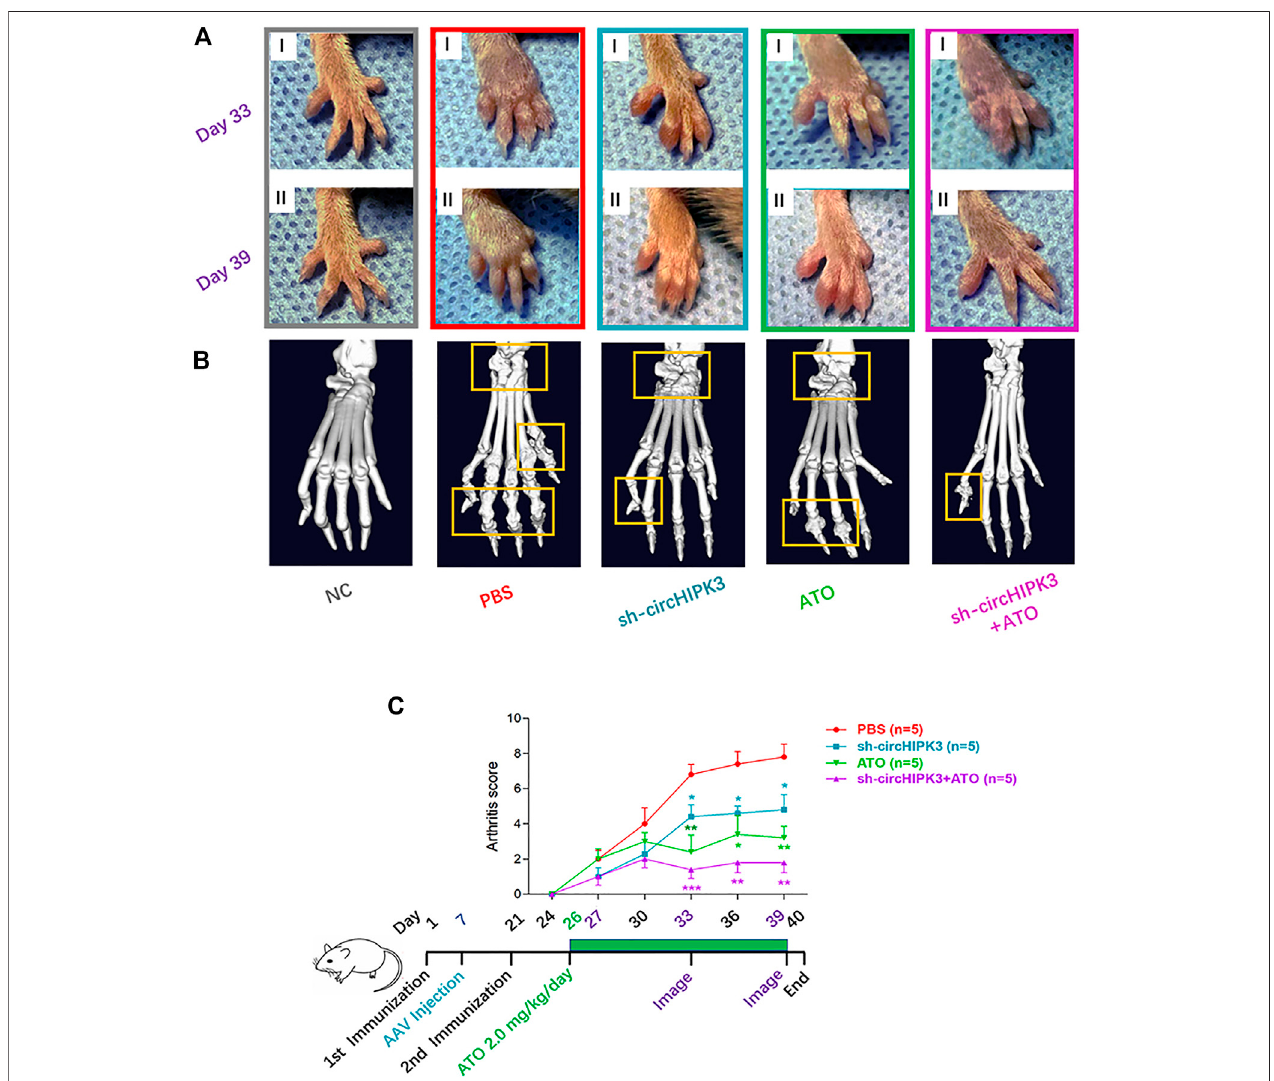
FIGURE5 | CircHIPK3knockdown or its combined application withATO alleviated the symptoms and jointdestruction ofCIA mice. (A) Representative pictures of the paws of mice showed that CIA developed rapidly in paws after the mice were immunized with collagen II and sustained to the end of the experiment. AAV-sh- circHIPK3, 2.0 mg/kg/day ATO administration, or the combination treatment of above two agents signi fi cantly alleviated the severity of arthritis compared with the CIA grouponday33( Ⅰ )andday39( Ⅱ )afterthe fi rstimmunization. (B) Themicro-CTimagesofpawsdemonstratedthedestructionoftheboneandcartilageinCIAmice, and ATO injection alleviated the joint destruction. AAV-sh-circHIPK3 intra-articular therapy in addition to ATO could evidently reduce the damages of bone compared with ATO therapy alone. (C) Clinical evaluation and the process diagram are demonstrated. Clinical arthritis scores showed that both ATO and intra-articular AAV-sh- circHIPK3 therapy could signi fi cantly reduce the arthritis scores of CIA mice. Moreover, combining ATO and AAV-sh-circHIPK3 reduced the arthritis score more signi fi cantly than ATO treatment alone (n (cid:1) 5; * p < 0.05, ** p < 0.01, *** p < 0.001 versus PBS group). Data are expressed as the mean ± SEM.